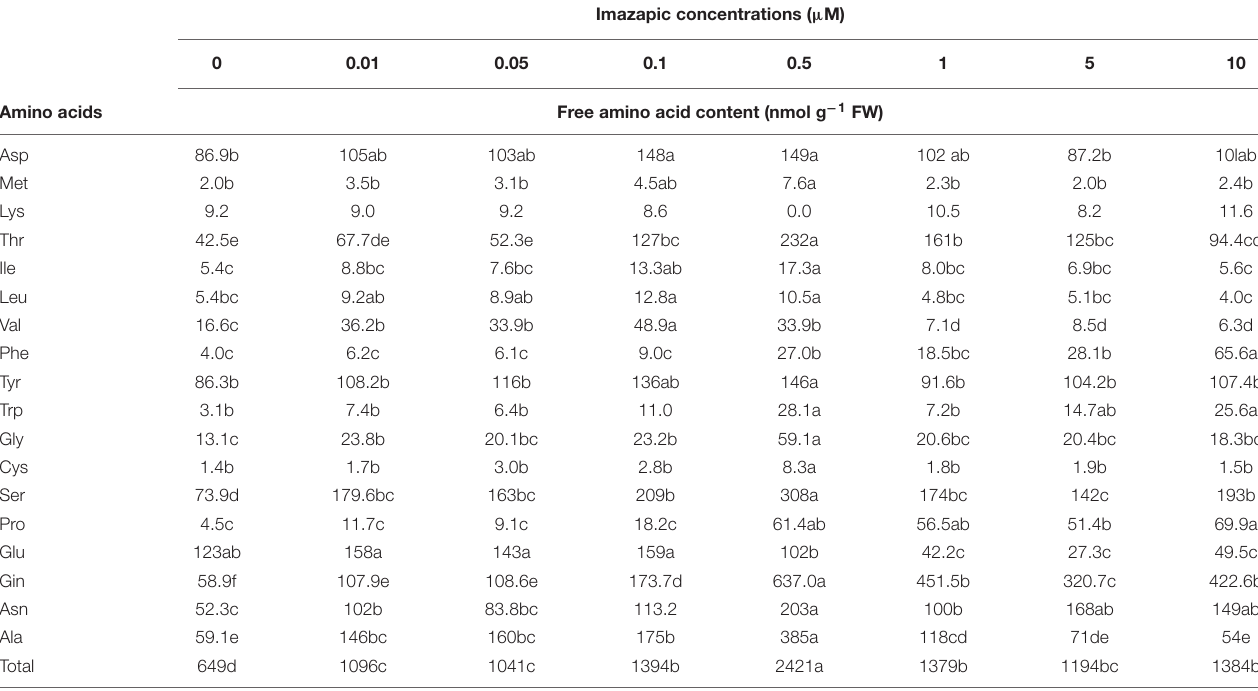
TABLE 3 | Free amino acid content in P. aegyptiaca callus grown in imazapic-containing